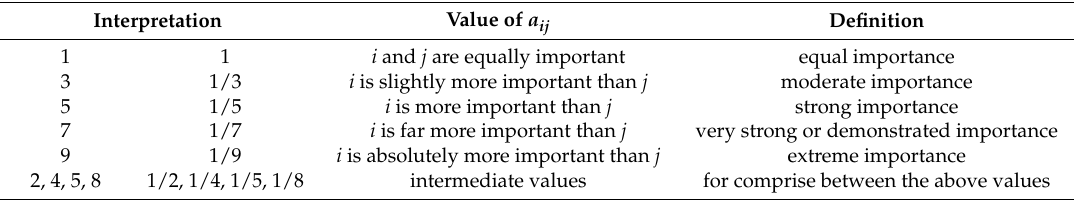
Table 1. Scale of relative importance (after